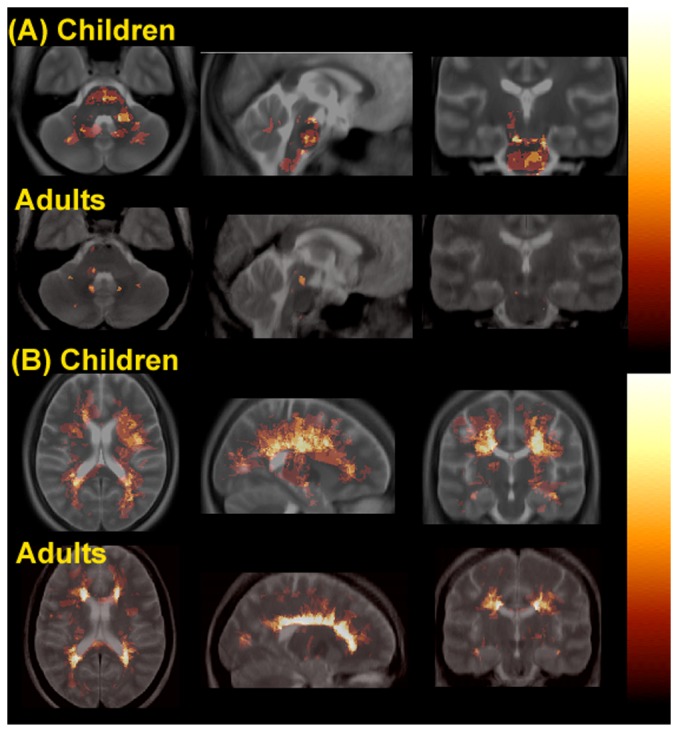
Lesion frequency maps (axial (left), sagittal (middle) and coronal (right) views) in the hot metal color scale showing the infratentorial (A) and supratentorial (B) T2-weighted lesion distributions in children with RRMS (rows 1 and 3) vs. adults with RRMS (rows 2 and 4), superimposed on the average T2-weighted structural images (in grey scale) for each group. The intensity of each voxel in the overlay represents the group frequency for lesions at each location.